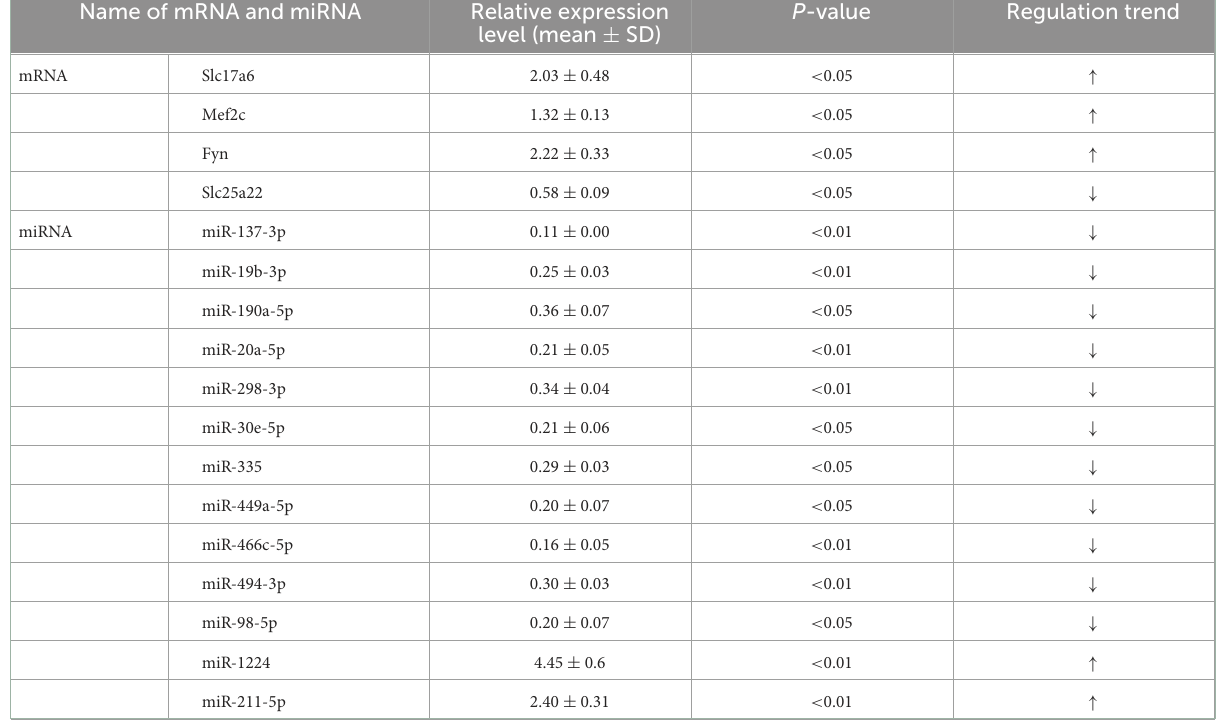
TABLE 4 Relative expression level of mRNA and miRNA detected in PTE experimental group. Name of mRNA and